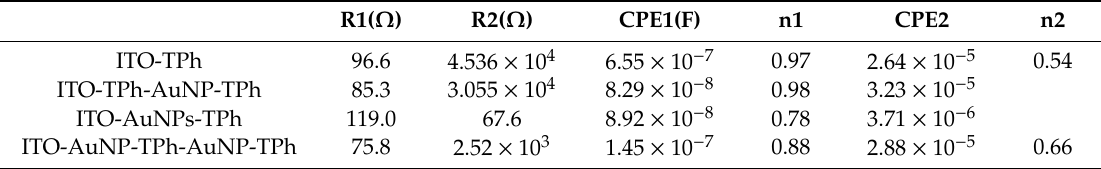
Table 1. Simulated values derived from Electrochemical Impedance Spectroscopy (EIS)